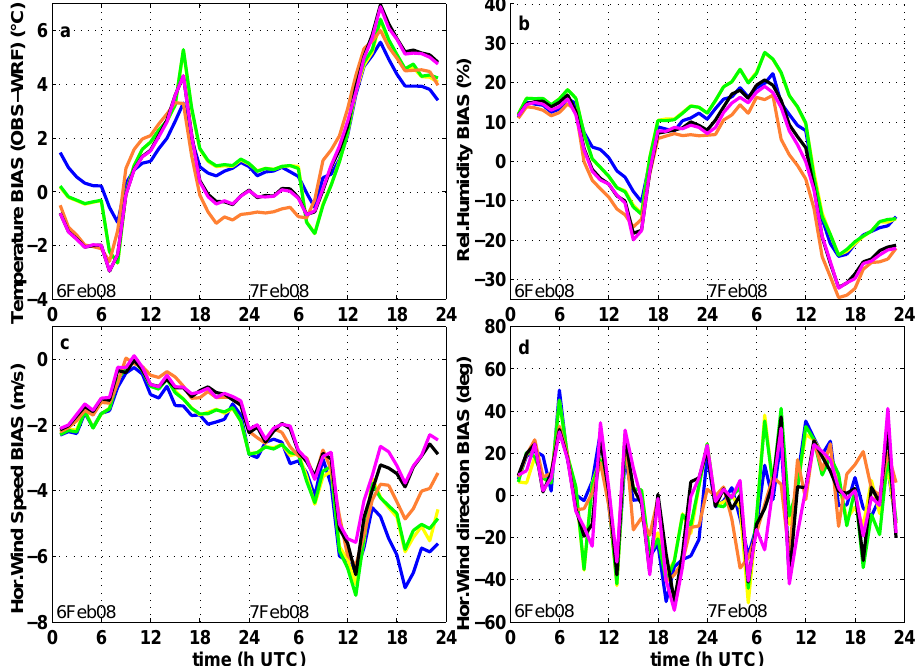
Fig. 13. Hourly averaged bias between SIARL observations and WRF results for 6–7 February 2008 for (a) 2m temperature ( ◦ C), (b) 2m relative humidity (%), (c) 2m horizontal wind speed (ms − 1 ), (d) 2m horizontal wind direction (deg). Color code: YSUtd is blue; YSUNoahNOURB is yellow; YSUNoahUCM1 is green; MYJtd is orange; MYJNoahNOURB is black; and MYJNoahUCM2 is pink.